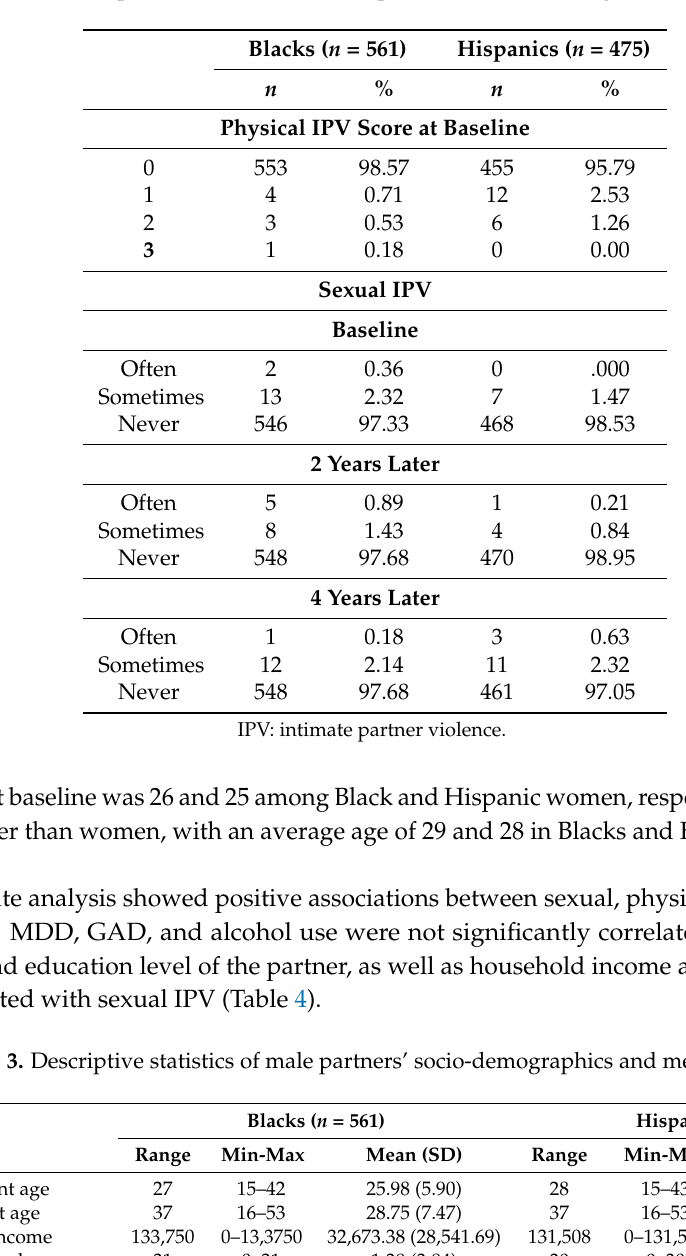
Table 2. Descriptive statistics of intimate partner violence among female partners.